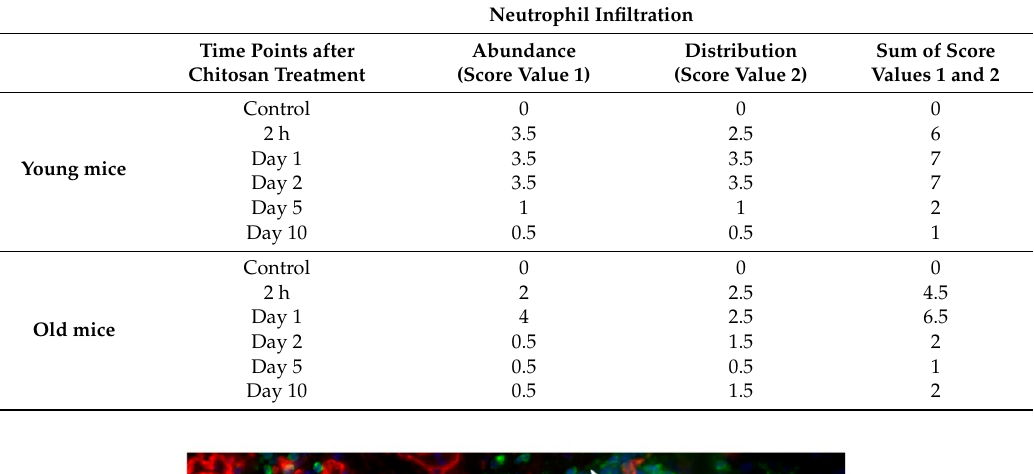
Table 1. Scoring results of neutrophil infiltration in the urinary bladder wall of young and old mice.